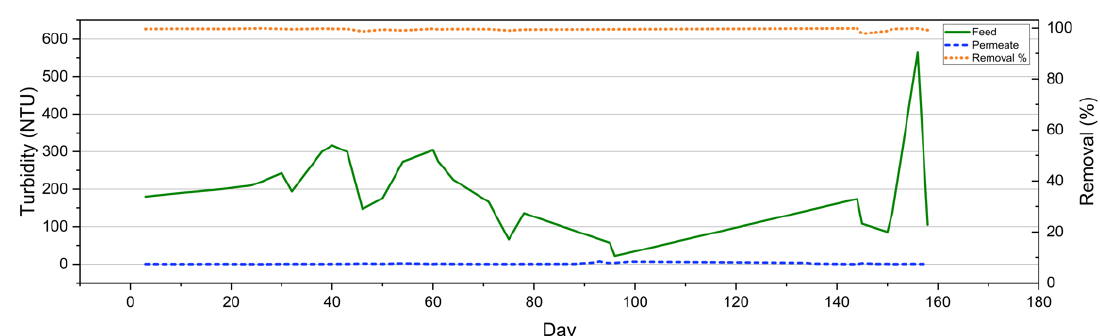
Figure 5. Removal and average of turbidity of feed and permeate during the